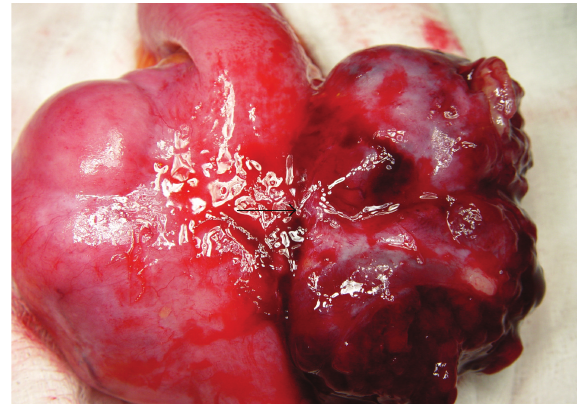
Figure 2: Intraoperative finding.